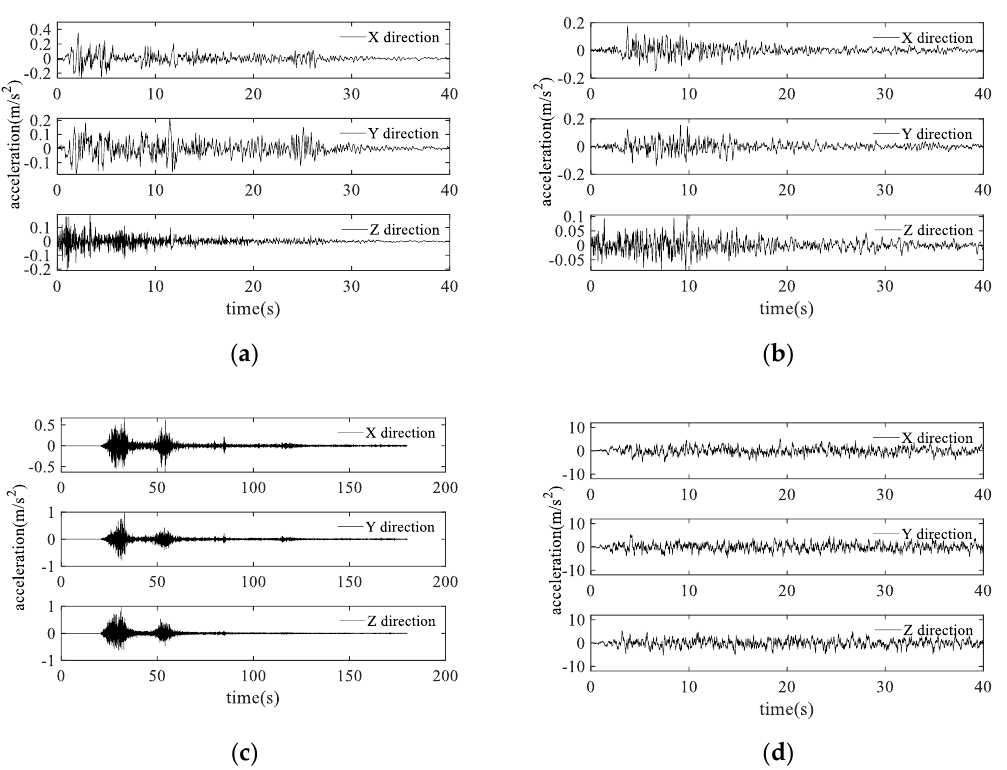
Figure 3. Time history of seismic wave acceleration: ( a ) El Centro wave; ( b ) Taft wave; ( c ) Wolong wave; ( d ) Artificial wave. Table 1. Arrangement of test conditions.